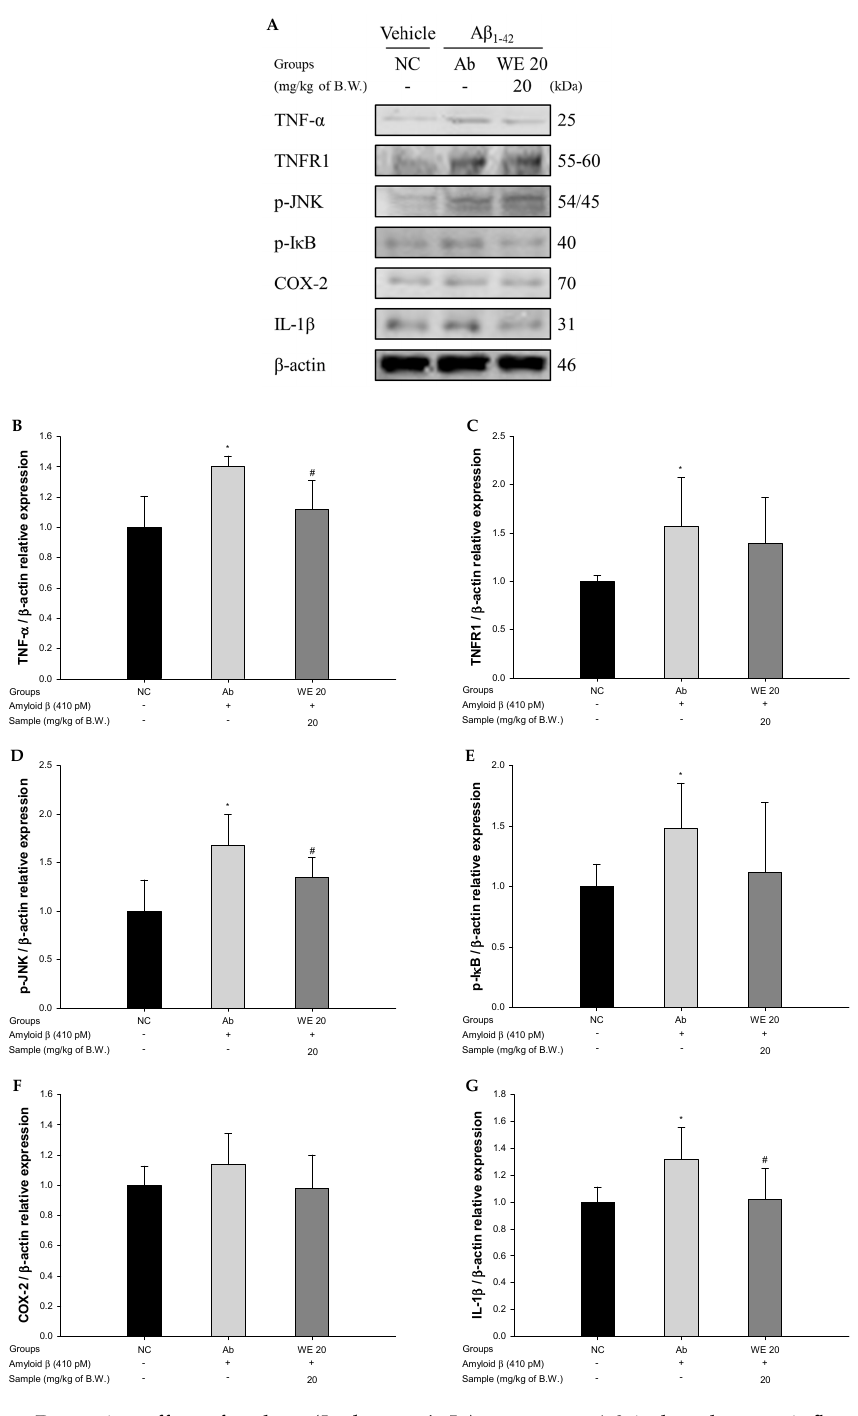
Figure 8. Protective effect of walnut ( Juglans regia L.) extract on A β -induced neuro-inflammation: ( A ) protein expression levels; ( B ) representative Western blots for total protein and expression of tumor necrosis factor-alpha (TNF- α ) ( B ), tumor necrosis factor receptor 1 (TNFR1) ( C ), phosphorylated c-Jun N-terminal kinase (p-JNK) ( D ), phosphorylated nuclear factor of kappa light polypeptide gene enhancer in B-cells inhibitor (p-I κ B) ( E ), cyclooxygenase-2 (COX-2) ( F ), and interleukin 1 beta (IL-1 β ) ( G ) in mice brain tissues. Results shown are means ± SD ( n = 3). Data are statistically represented at * = significantly di ff erent from the NC group; # = significantly di ff erent from Ab group, respectively; * and # p <